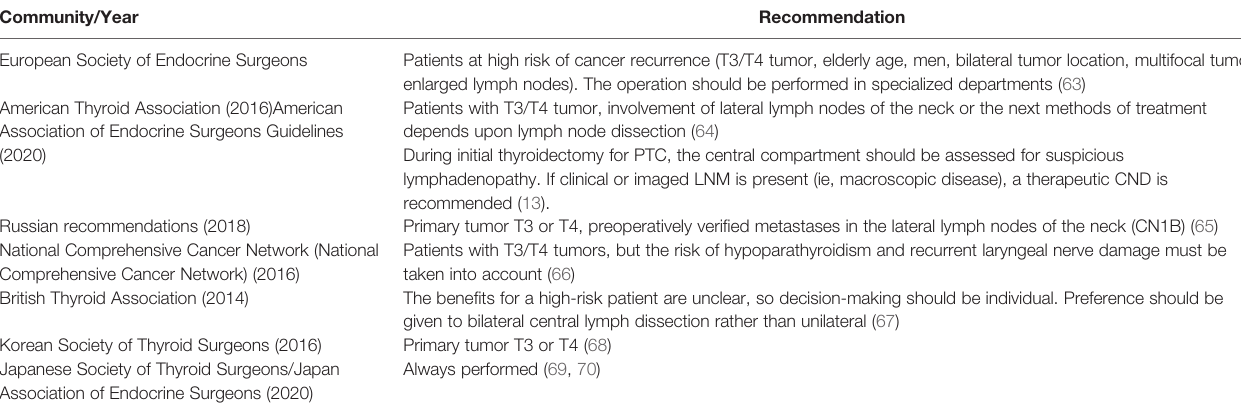
TABLE 3 | Recommendations for central lymph dissection.